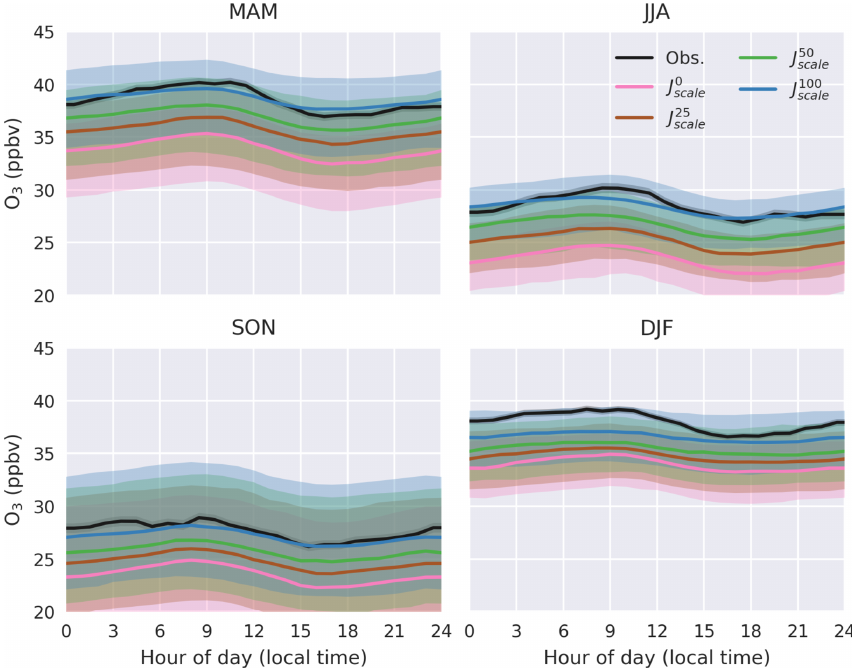
Figure 9. Observed and modeled seasonal cycle of O 3 at CVAO during 2014–2015. Solid lines represent median values, and shaded regions show first and third quartiles of model values and standard error of